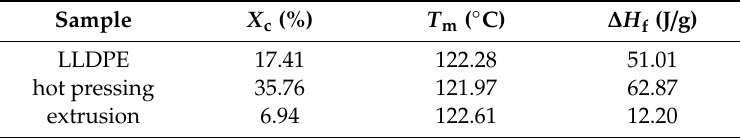
Table 1. Melting enthalpy and temperature of straw / LLDPE composite.